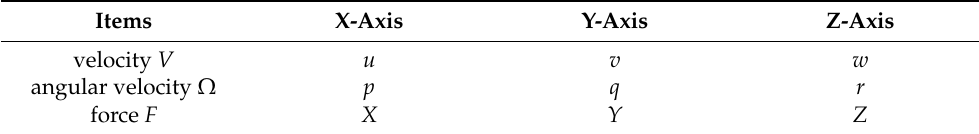
Table 1. Motion parameters and ROV body reference system components of force.